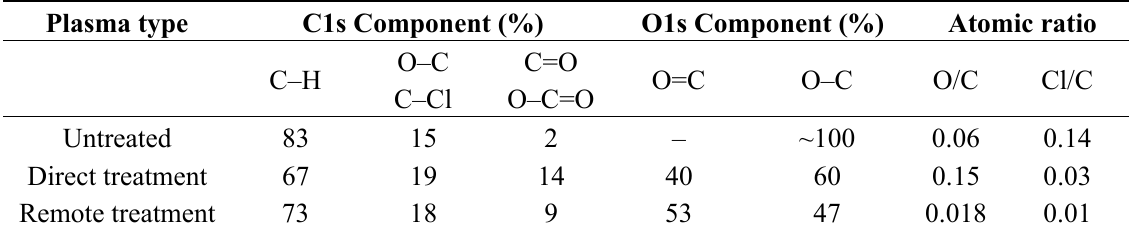
Table 1. X-ray photoelectron spectroscopy atomic composition of remote and direct argon plasma treated PVC at 60 W for 3 min (Adapted from Ru et al.